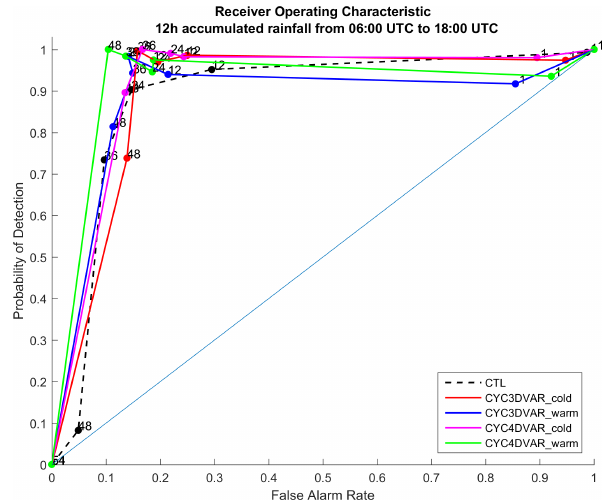
Figure 10. The receiver operating characteristic curves (ROC) are computed for the CTL (black), CYC3DVAR_cold (red), CYC3DVAR_warm (blue), CYC4DVAR_cold (magenta) and CYC4DVAR_warm (green). The 12-hourly accumulated precipita- tion from 06:00 to 18:00UTC on 3 May 2018 are used to build the